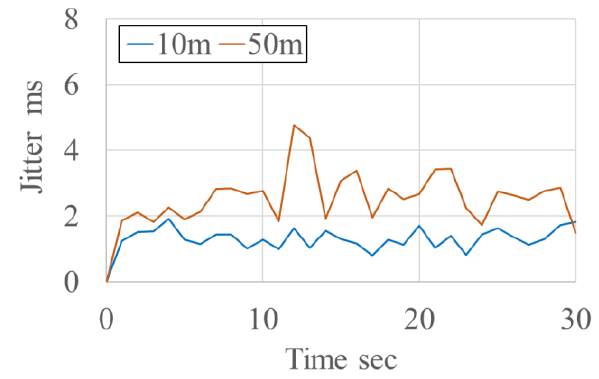
Figure 20. Temporal evolution of UDP jitter in each communication distance (Sender is PC): The blue line is the 10 m results, and the orange line is the 50 m results.